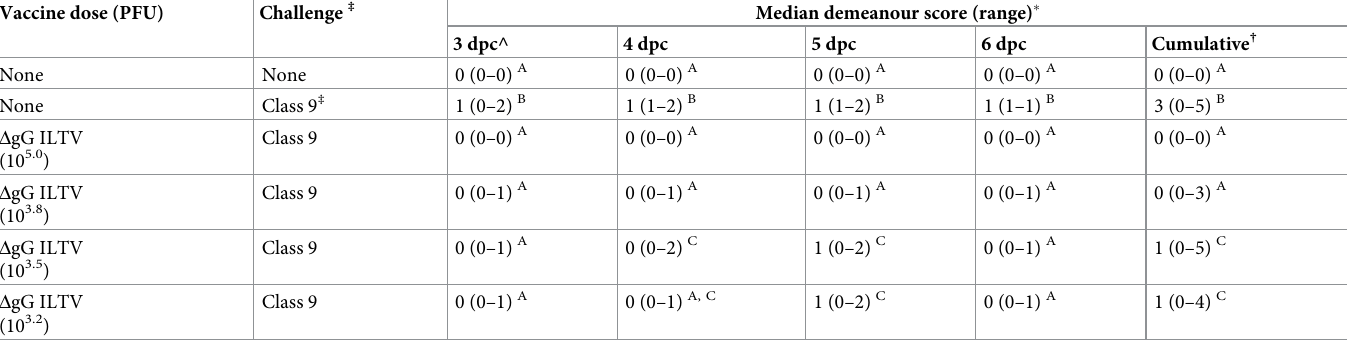
Table 1. Scores for demeanour on days 3 to 6 after challenge in unvaccinated birds and in birds vaccinated with different doses of the Δ gG ILTV vaccine adminis- tered via eye-drop. Vaccine dose (PFU)